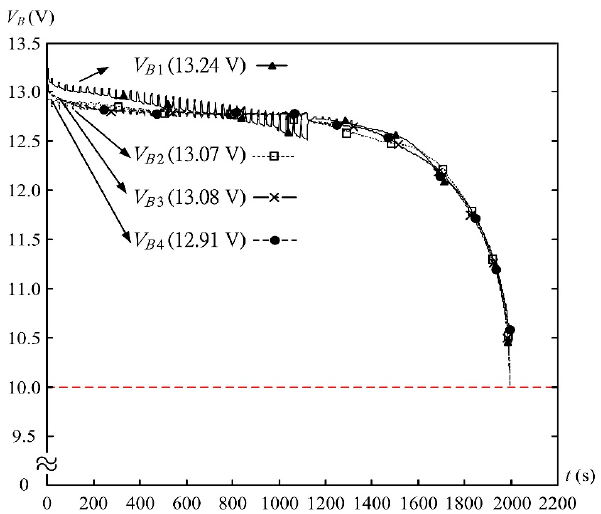
Figure 10. Battery voltages with balanced discharging.